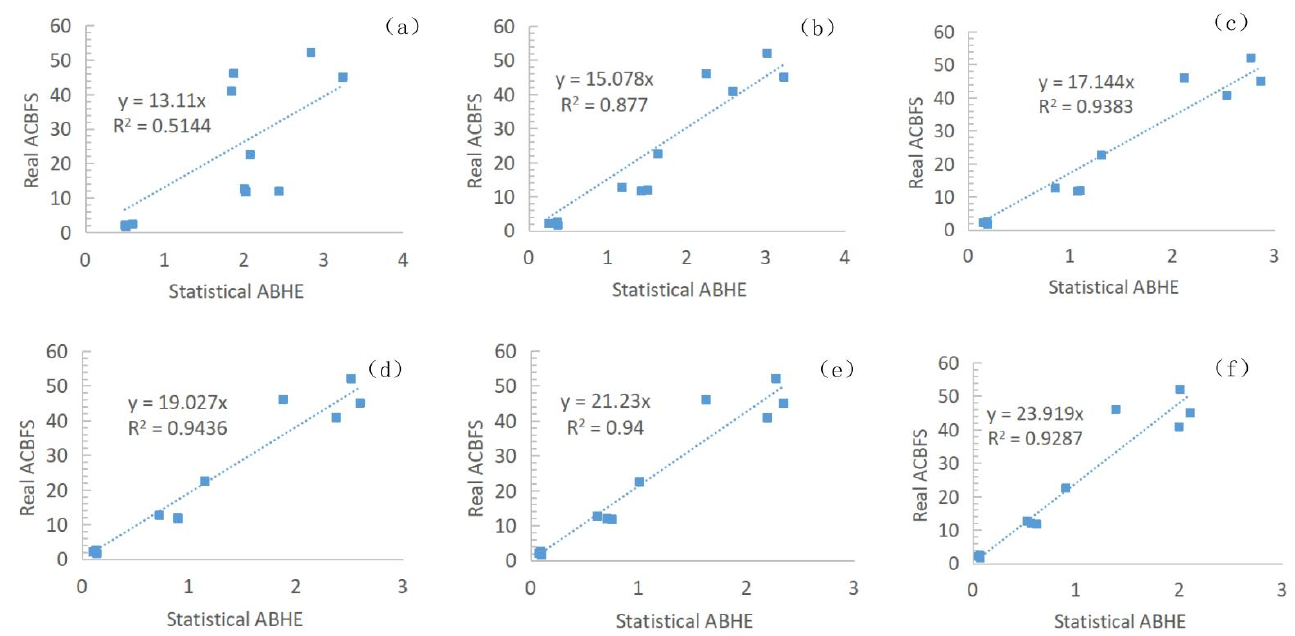
Figure 12. The fit curve between statistical results and real situations. ( a ) Fitting analysis result of the Statistical ABHE (based on the first non-building exclusion method) and the real ACBFS; ( b ) Fitting analysis result of the Statistical ABHE (based on the second non-building exclusion method and the exclusion threshold is 7 m) and the real ACBFS; ( c ) Fitting analysis result of the Statistical ABHE (based on the second non-building exclusion method and the exclusion threshold is 11 m) and the real ACBFS; ( d ) Fitting analysis result of the Statistical ABHE (based on the second non-building exclusion method and the exclusion threshold is 14 m) and the real ACBFS; ( e ) Fitting analysis result of the Statistical ABHE (based on the second non-building exclusion method and the exclusion threshold is 17 m) and the real ACBFS; ( f ) Fitting analysis result of the Statistical ABHE (based on the second non-building exclusion method and the exclusion threshold is 20 m) and the real ACBFS.